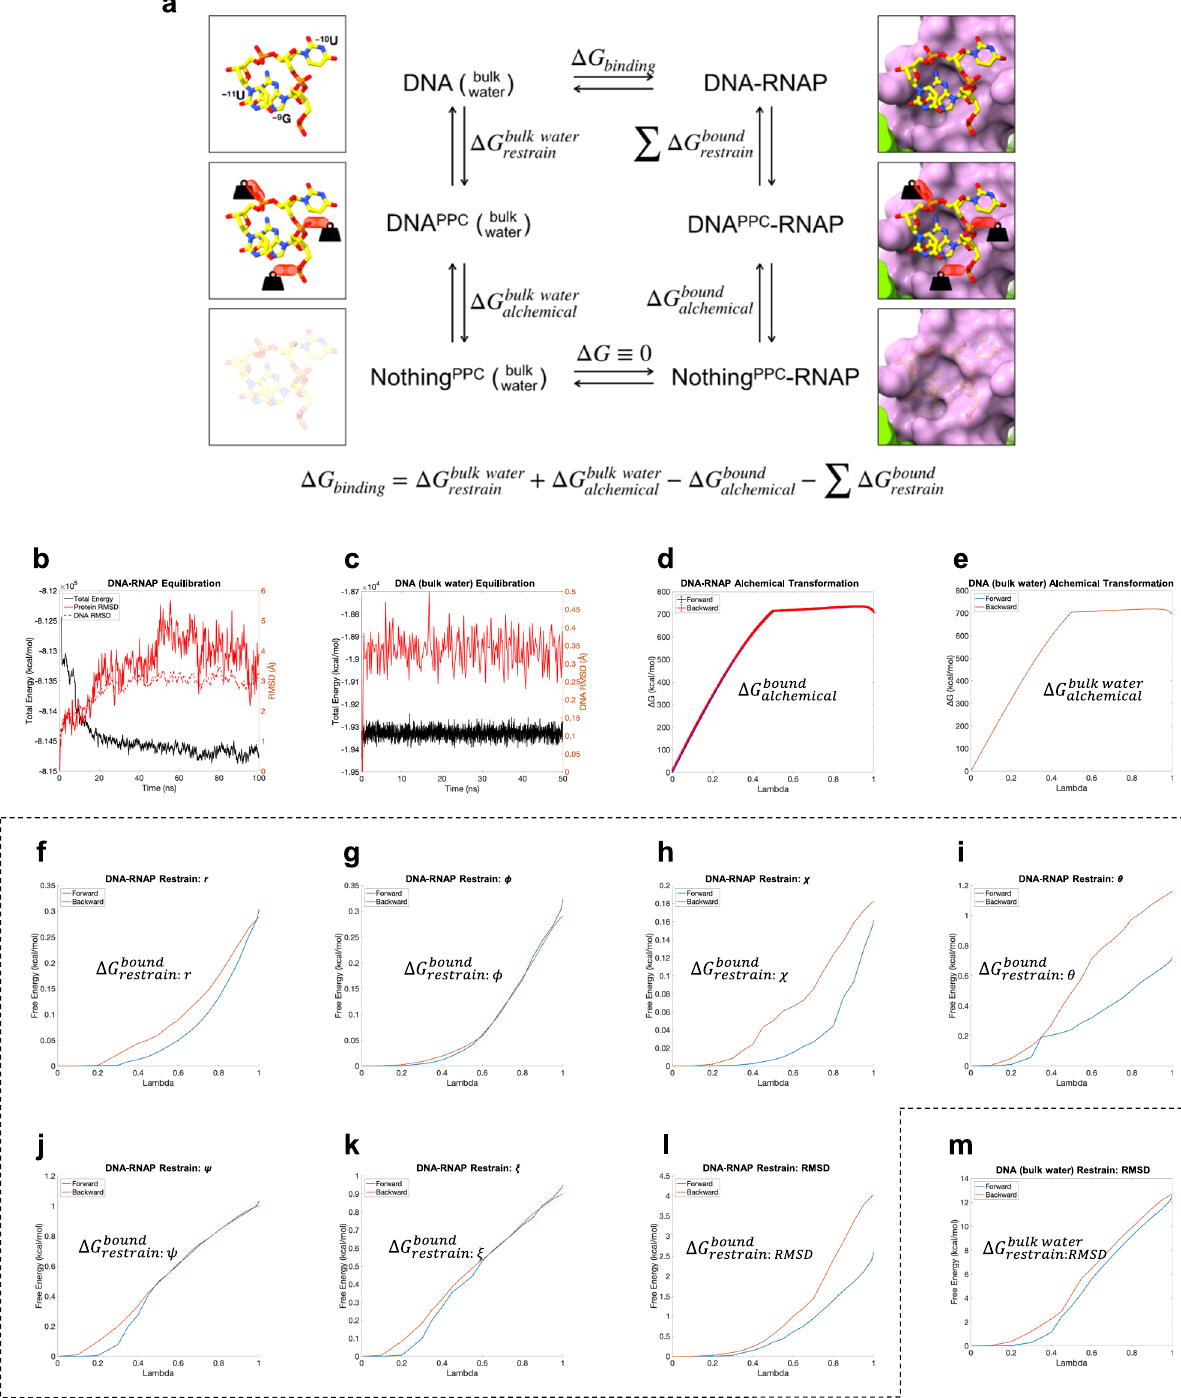
Fig. 9 Derivation of the promoter binding free energy using molecular dynamics. a Thermodynamic cycle of promoter binding. The PPC superscript (e.g. DNA PPC ) stands for Promoter Pocket Conformation in regard to the structure of the 3 ′ - − 11 UUG − 9 -5 ′ DNA trinucleotide. b Equilibration and relaxation of the cryo-EM derived atomic model of the AR9 nvRNAP holoenzyme with the 3 ′ - − 11 UUG − 9 -5 ′ DNA trinucleotide bound to the promoter pocket. c Equilibration and relaxation of the 3 ′ - − 11 UUG − 9 -5 ′ trinucleotide in bulk water. d , e Energetics of forward and backward alchemical transformations of the 3 ′ - − 11 UUG − 9 -5 ′ DNA trinucleotide in the promoter pocket of the AR9 nvRNAP holoenzyme and in the PPC in bulk water, respectively. f – l Entropic cost of applying seven harmonic constraints to the 3 ′ - − 11 UUG − 9 -5 ′ DNA trinucleotide to maintain it in the promoter pocket-bound state. m Entropic cost of the harmonic RMSD constraint on the 3 ′ - − 11 UUG − 9 -5 ′ DNA trinucleotide to maintain the PPC.